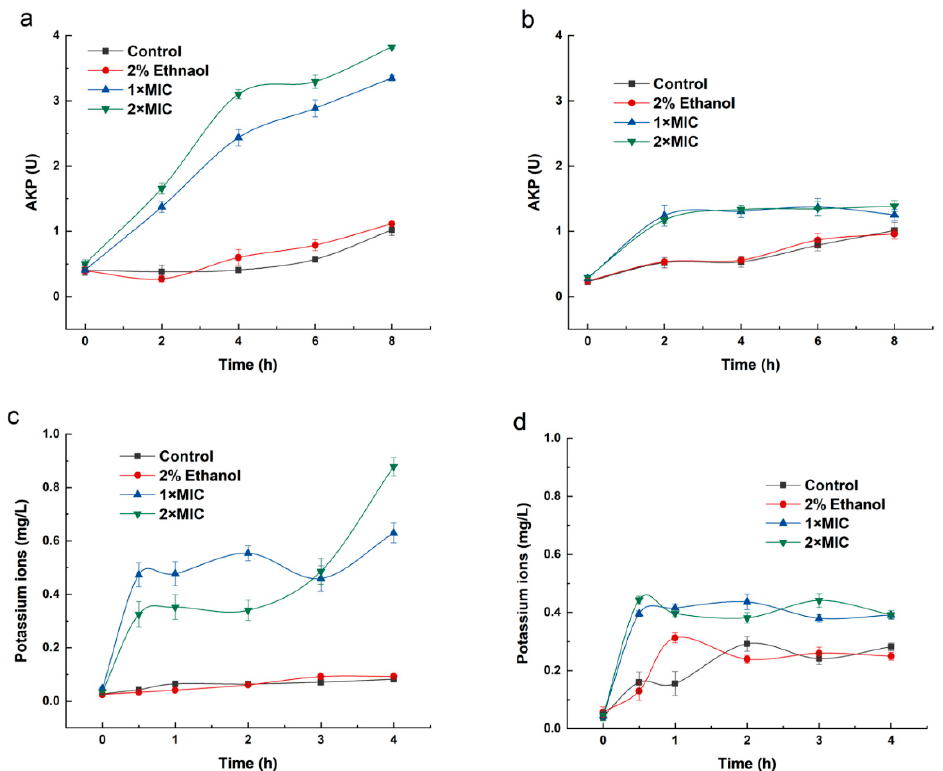
Figure 2. Alkaline phosphatase (AKP) activity of bacteria before and after 3-carene treatment: ( a ) B. thermosphacta , ( b ) P. fluorescens . Relative amount of potassium ions released by bacteria treated with 3-carene: ( c ) B. thermosphacta , ( d ) P. fluorescens